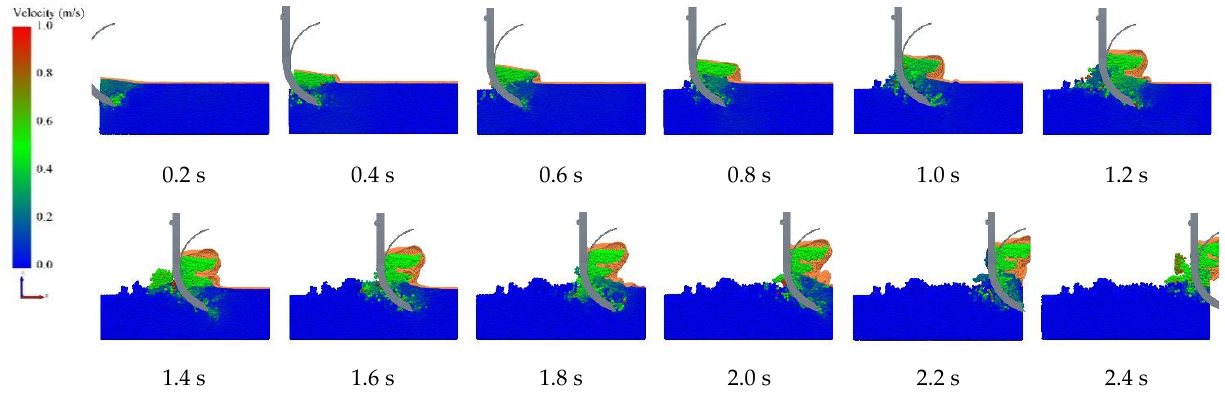
Figure 6. Soil disturbance and migration behaviors at different times under the action of the hug plate film-lifting parts.